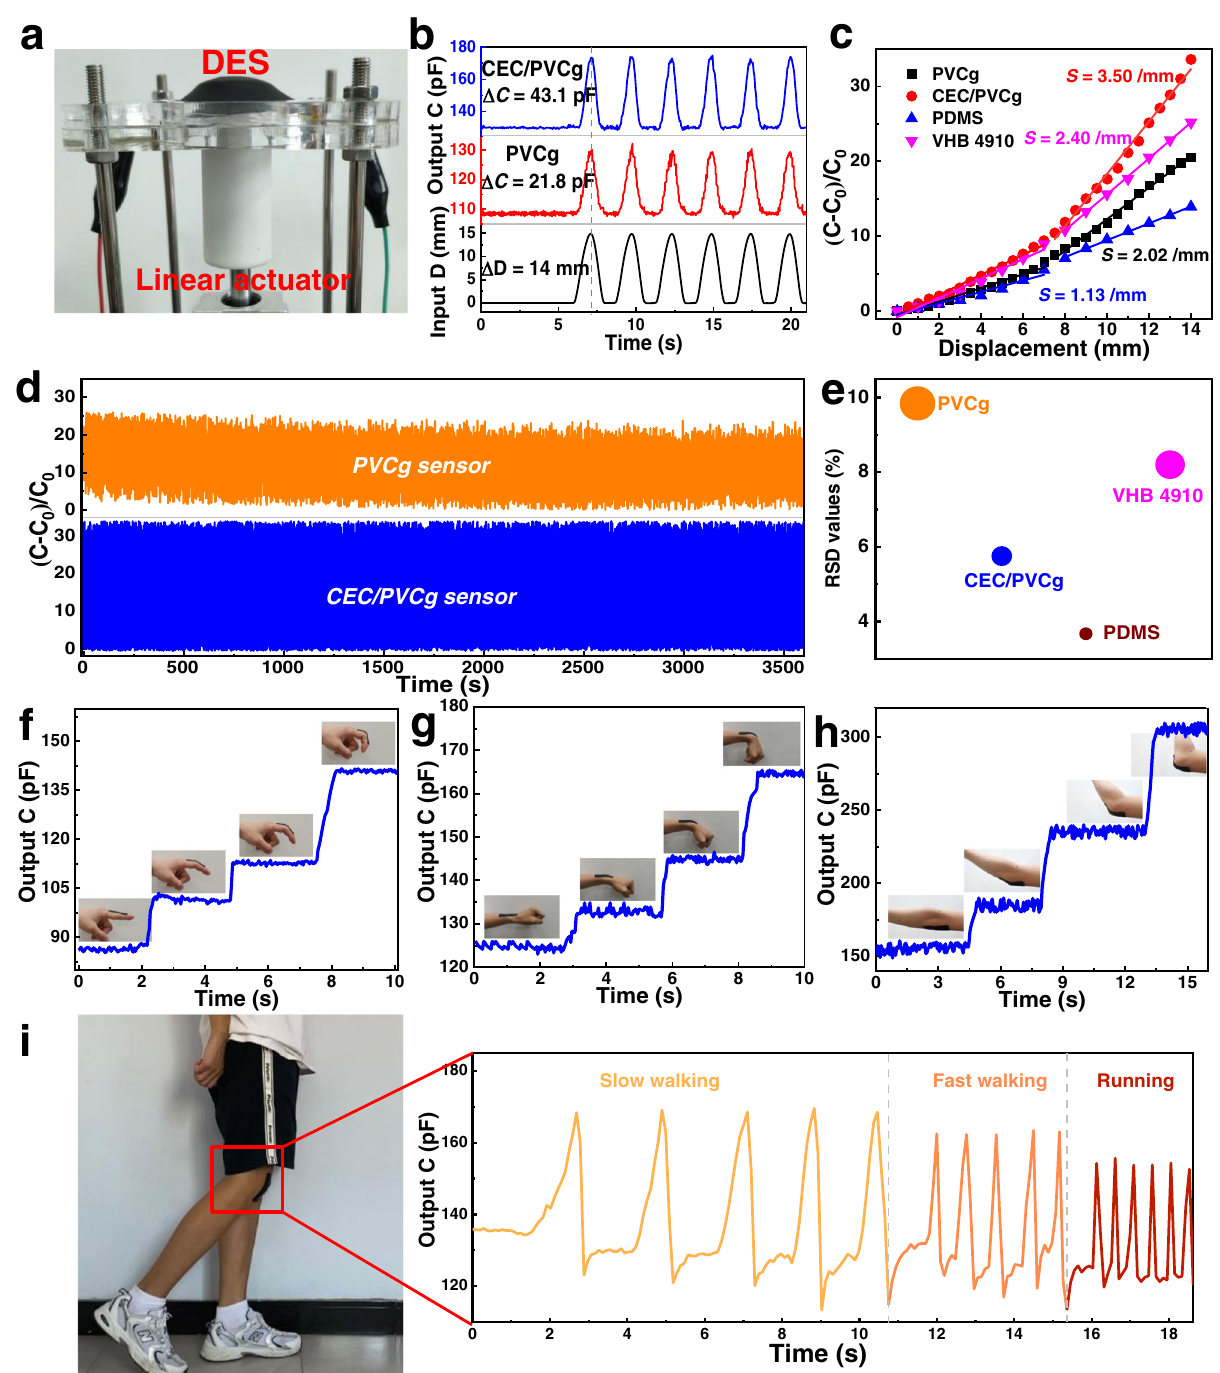
Fig. 6 | Sensing test. a A photograph of the DES device consisting of a linear actuator to applyperiodic strains tothe PVCg and CEC/PVCg-basedsensors. b The inputstraincurvefromlinearactuatorandoutputcapacitancecurvesgeneratedby the PVCg and CEC/PVCg sensors. c The relative capacitance ( C - C 0 / C 0 ) values that weregeneratedbythePVCg,CEC/PVCg,PDMS,andVHB4910sensorsasafunction of the strain. The tangentialslope of the curve wasde fi nedasthe sensitivity (/mm) of the sensors. The values of sensitivity (S) in the displacement range of 7 – 14 were calculated and marked in the fi gure. d Duration test within 1440 cycle fl ections